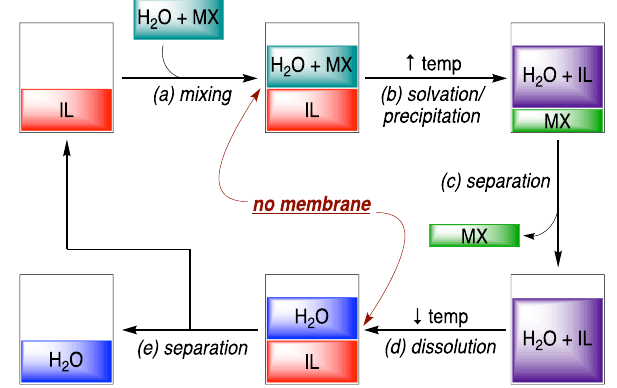
Fig. 1 Schematic of DSE desalination process employing TSIL. DSE